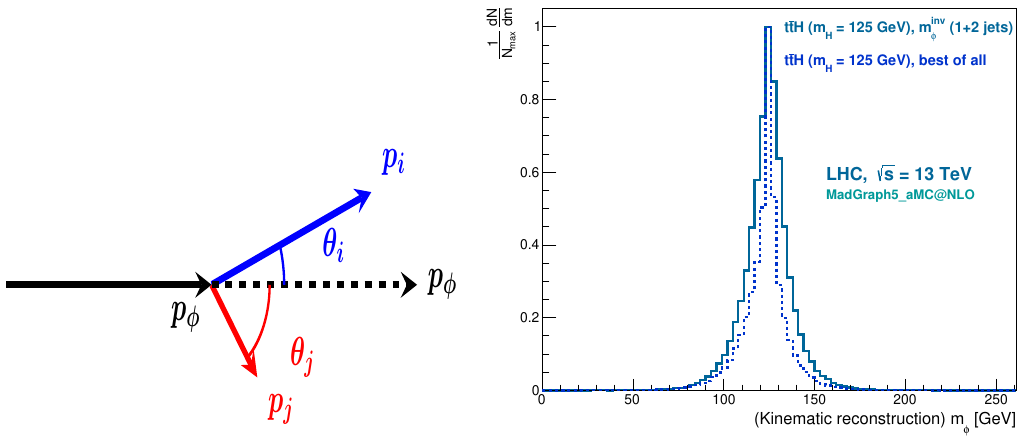
Figure 3 . (Left) Schematic representation of the φ boson decay and angles between the Higgs and its decay products; (right) SM Higgs boson mass distribution after kinematic reconstruction, for m φ = 125 GeV. The solid line shows the best invariant Higgs mass from one or two jets i.e., m inv (1+2 jets) = m inv (1 jet) or m inv (2 jets), and the dashed line represents the best of all methods φ φ (best of all) introduced in [60], φ = H